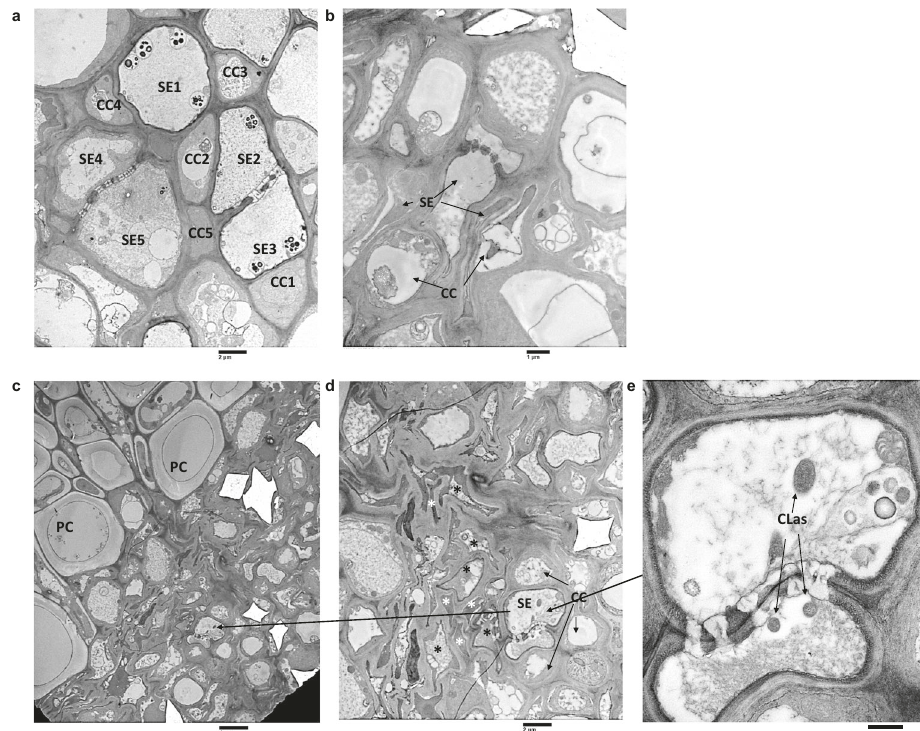
Fig. 2 Transmission Electron Microscopy (TEM) analysis of asymptomatic young leaves of CLas-infected Citrus sinensis . a Heathy leaf of C. sinensis “ Valencia ” . CC (companion cells): typical healthy companion cells with large central nucleus, dense cytoplasm, numerous mitochondria. SE (sieve element 1 – 3): typical sieve elements showing parietal “ s ” plastids, centrally distributed p protein, and lateral sieve plate showing minimum callose. SE (4 – 5): developing sieve elements showing plastids with no starch, intact central vacuole, and non-dispersed phloem protein. b Asymptomatic young leaf of CLas- infected C. sinensis . CC undergoing cell death. c , d , e Asymptomatic young leaves showing cell death of sieve element cells and companion cells, but not parenchyma cells (PC). Black * indicates cell death of sieve element cells. White * indicates cell death of companion cells. d Enlarged section of C showing both intact sieve element and companion cells as well as sieve element and companion cells undergoing cell death. e Enlarged section of D showing intact sieve element cells containing CLas. Experiments were repeated more than three times with similar